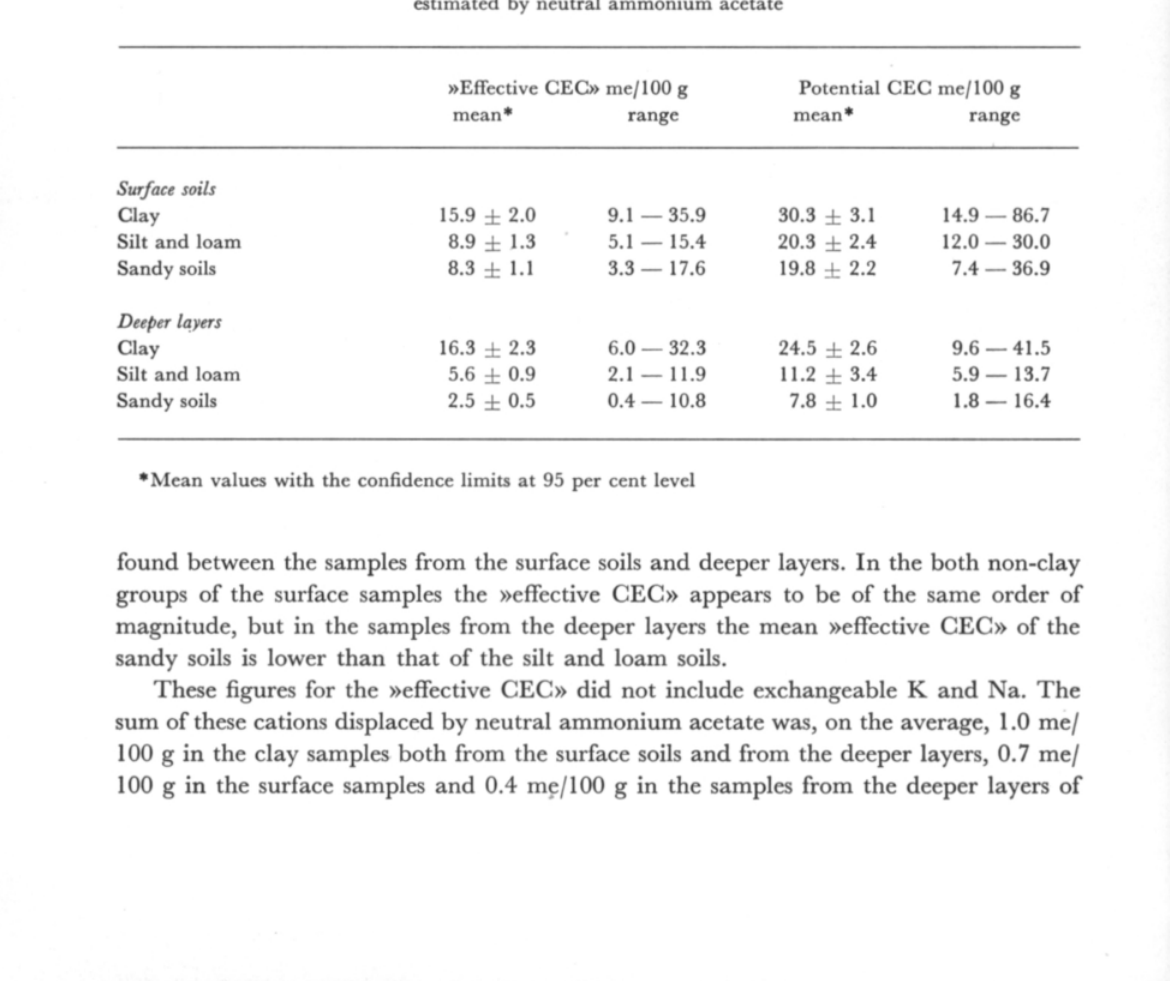
Table 2. »Effective CEC» as sum of (Ca + Mg) and (AI + H) displaced by N KCI and potential